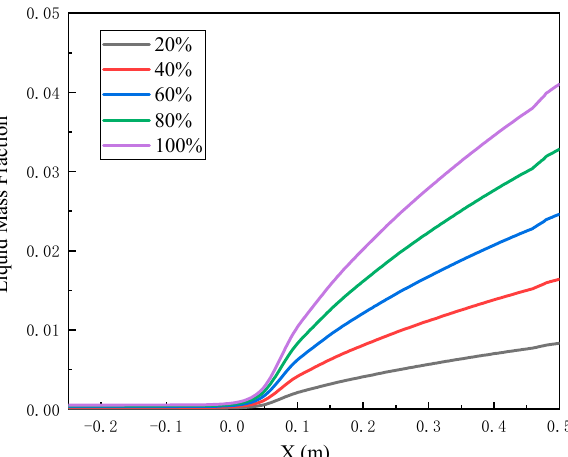
Figure 10. Liquid mass fraction distribution along the Moore type “B” nozzle centerline for several